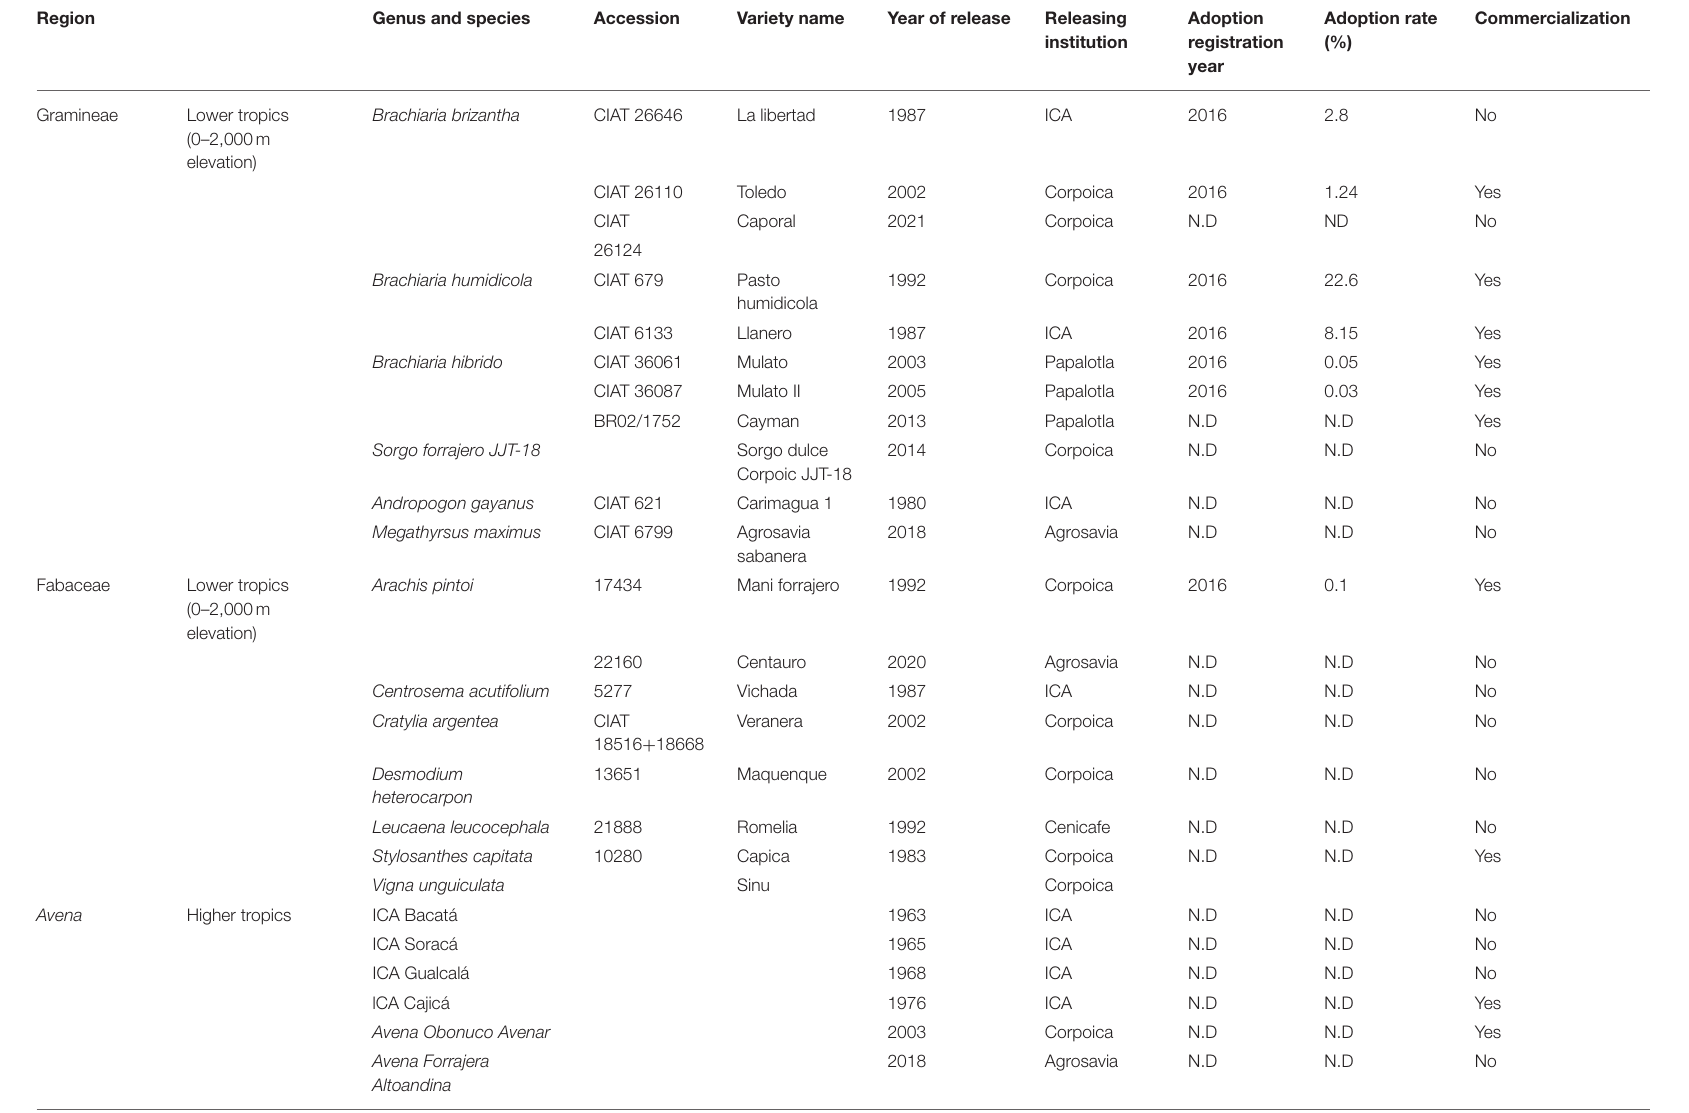
TABLE 1 | Forage species released in Colombia. Region